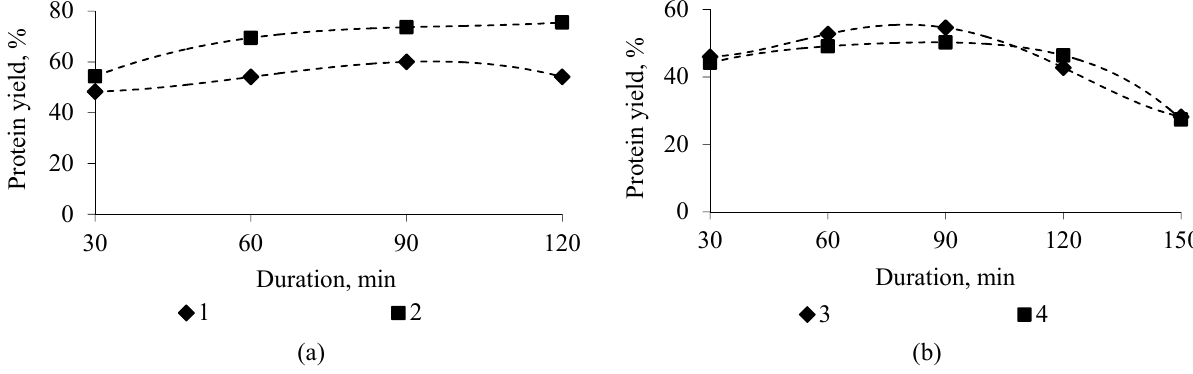
Fig. 10. Effect of duration of the process of alkaline (a) and acid (b) extraction on the yield of protein substances